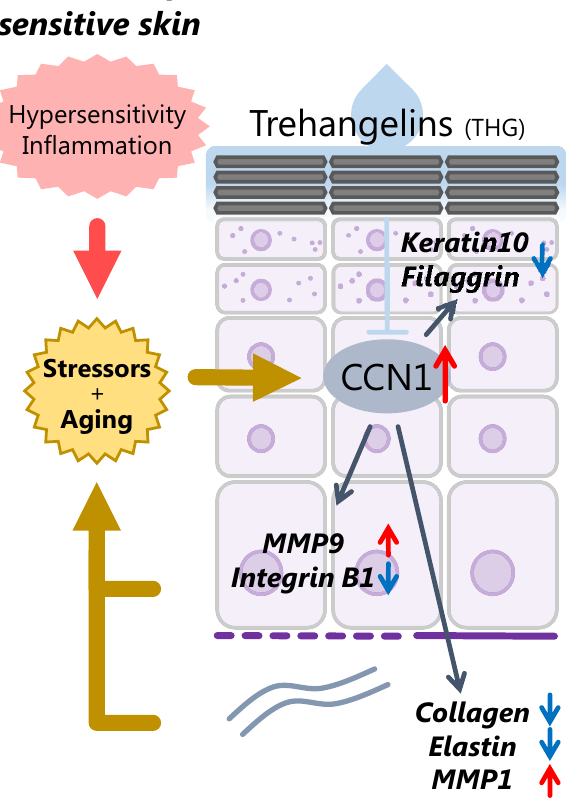
Figure 6. Graphical model of CCN1 driven aged and sensitive skin and the effect of